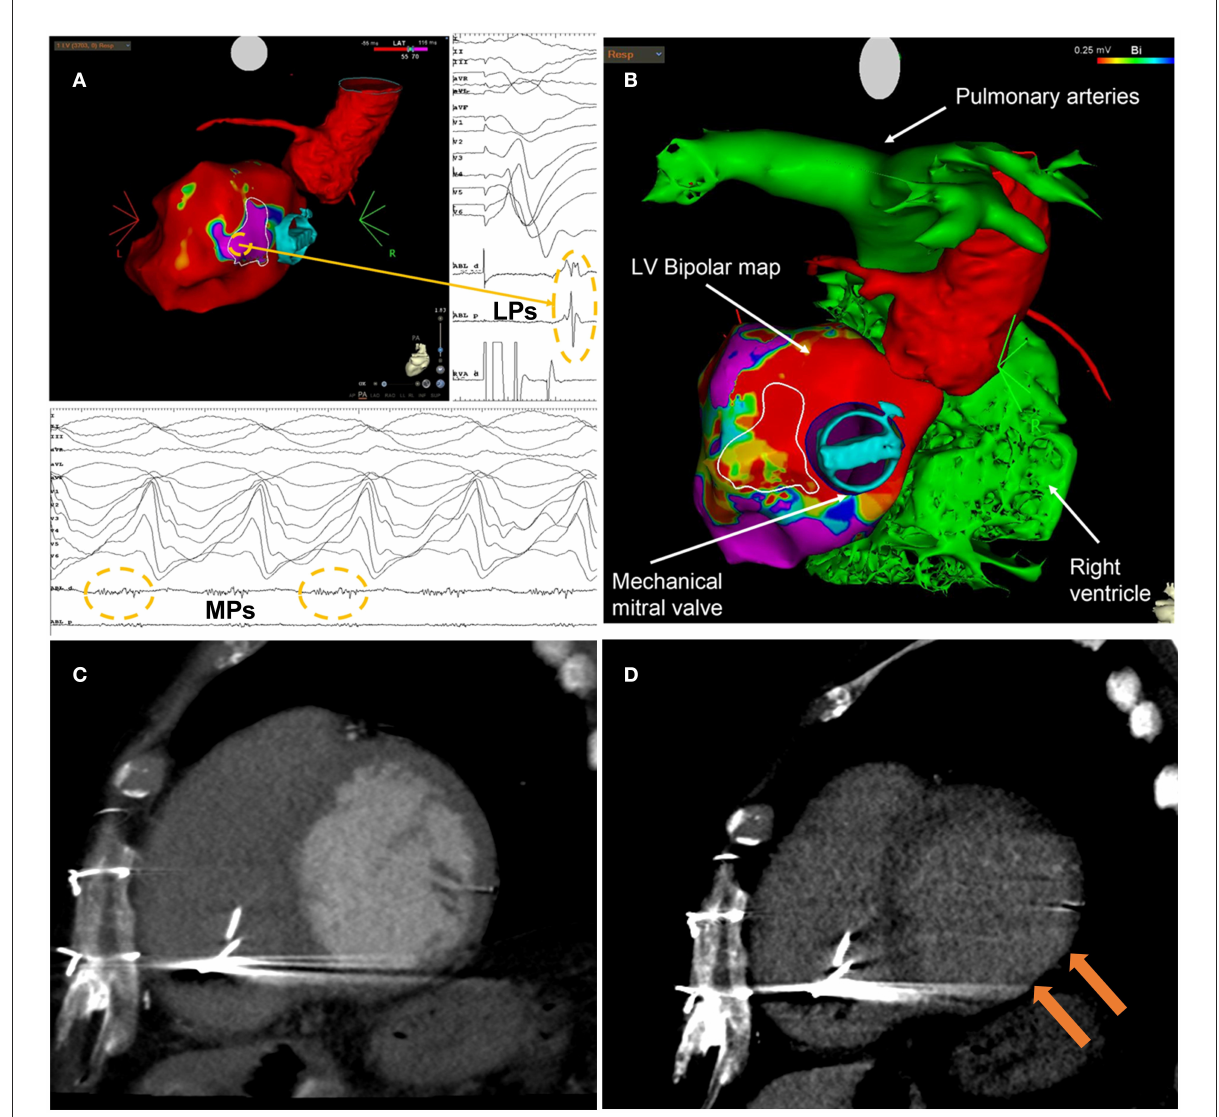
FIGURE2 (A) Endocardial electroanatomic substrate map (CARTO3, Biosense Webster, Irvine, CA, USA) obtained from the second VT ablation procedure. The map highlights the area of late potentials (LPs) characterized by a local late activation time (LAT) after paced QRS end, located at the basal inferolateral segment of the left ventricle. Mesodiastolic potentials (MPs) recorded during the clinical VT were located at the same spot of the farthest LPs. (B) Integration of CT imaging with CARTO imaging data (bipolar voltage map). In both (A,B) , the white outlined area is the arrhythmogenic target for STAR identified at EAM mapping. (C) LV short axis view of cardiac CT angiographic phase with thinned basal inferolateral myocardium. (D) LV short axis view of late cardiac CT phase with hyperdensity on basal inferior-lateral wall that represents transmural